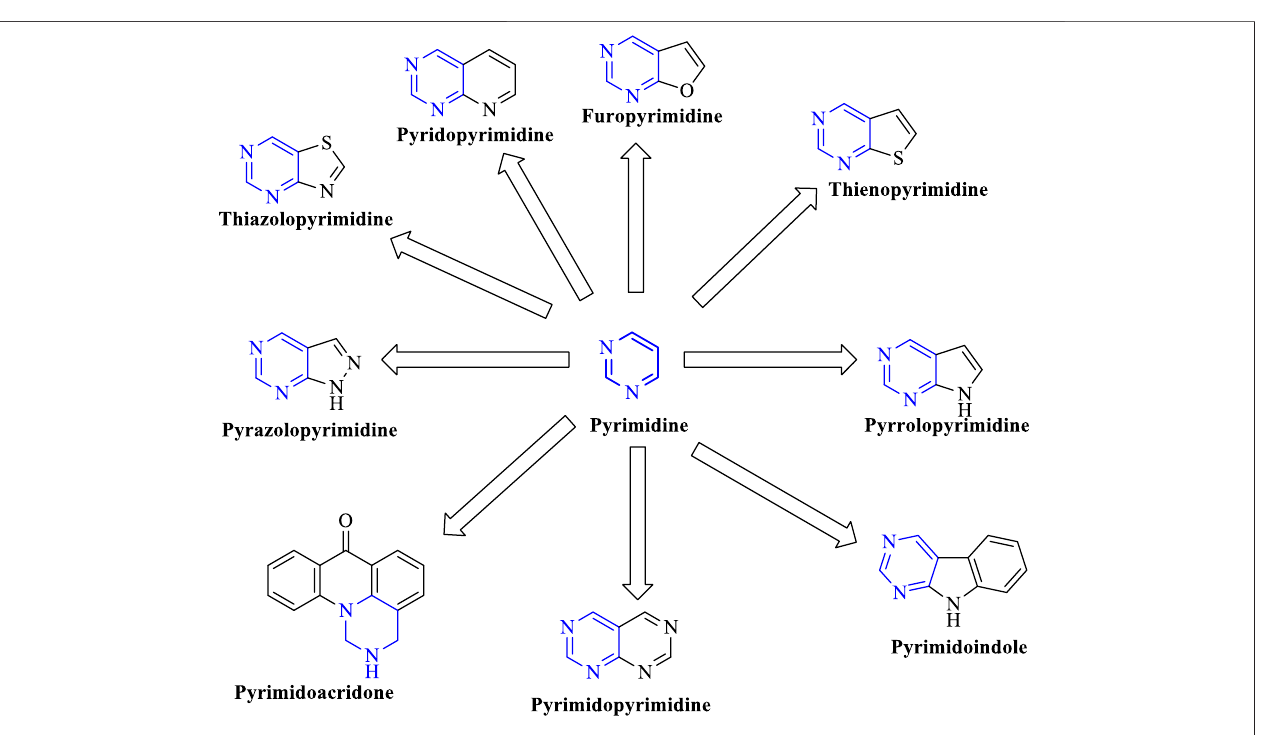
FIGURE 3 | Exhibits various fused-pyrimidine systems that have been reported as EGFR